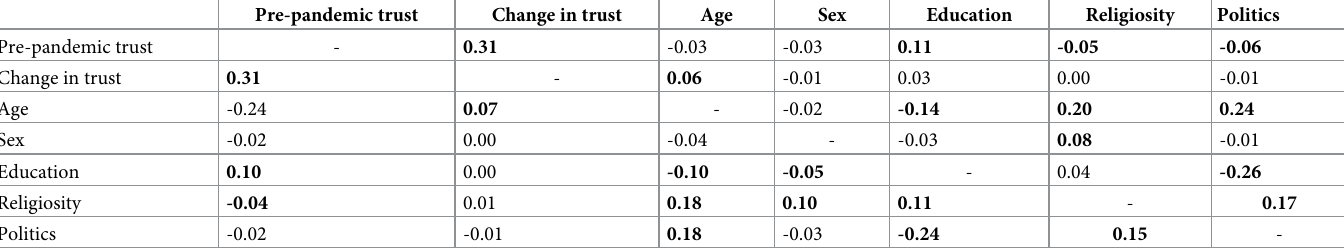
Table 1. Correlation and partial correlation between pre-pandemic trust score and change in trust score, controlling for age, sex, educational attainment, political attitude and religiosity. Values above the diagonal are Spearman’s rho values. Values below the diagonal are pairwise partial correlations controlling for the rest of vari- ables. Values in bold are significant at P < 0.05, N = 2039. Scoring system as follows: respondent age was recorded directly as the numerical value; sex was scored with a binomial system (0 = males, 1 = females); educational attainment recorded as degree level (+2), non-degree level (+1) or no qualification (0); religiosity recorded as: reli- gious and practising (+2), religious but not practising (+1), non-religious (0). Politics is scored from -1 to +1, more positive implying more right wing based on 10 attitudi- nal questions (Methods).